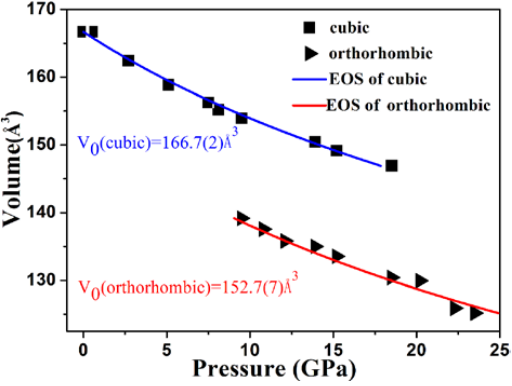
Figure 5. Unit-cell volume as a function of pressure determined for the CaF 2 nanocrystals. Solid curves are the Birch–Murnaghan EOS fits to the experimental data.